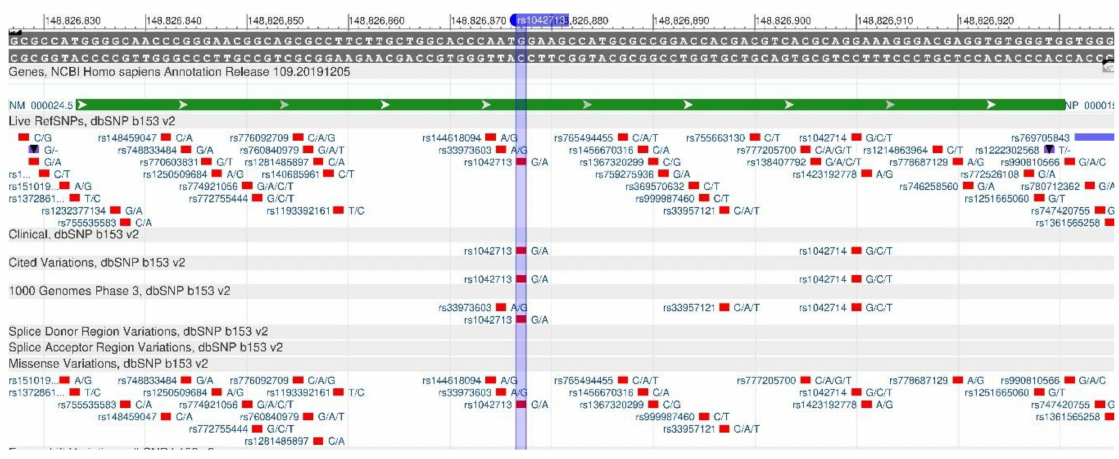
Figure 2. A portion of the ADRB2 gene (located on the long (q) arm of chromosome 5) containing the oligonucleotide polymorphism rs1042713.